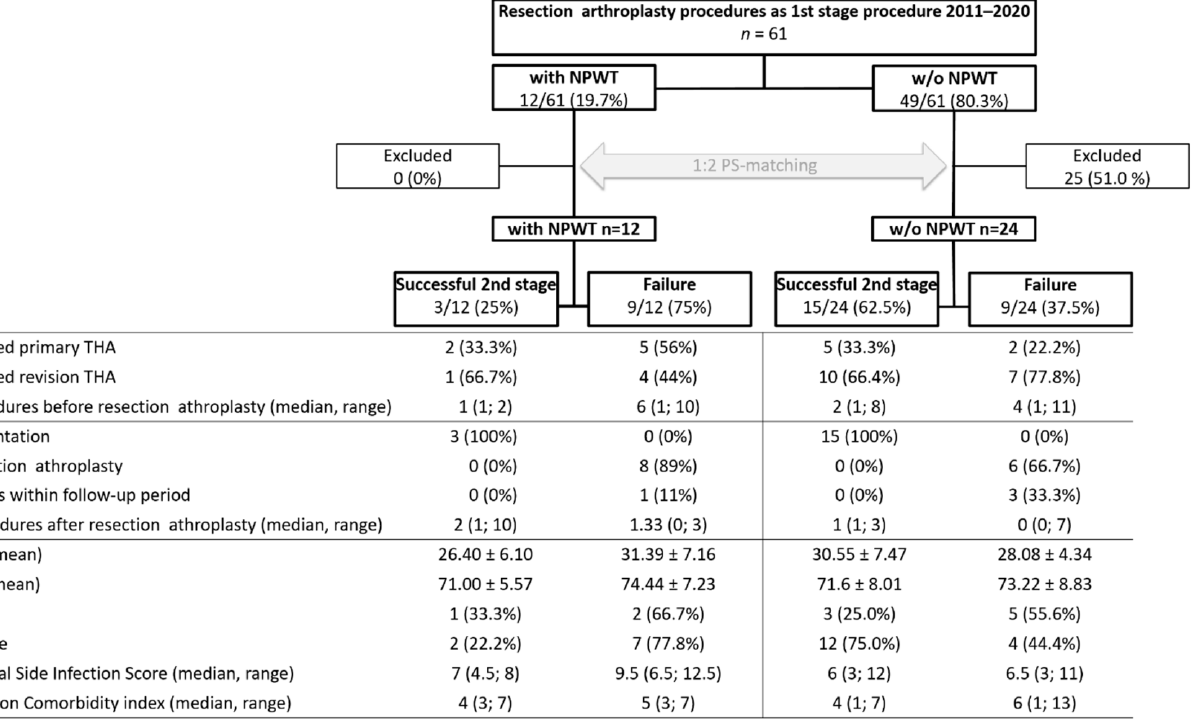
Figure 3. Comparison of risk factors between patients who received negative-pressure wound therapy (NPWT) and patients who did not receive NPWT (w/o) group before and after propensity-score (PS)